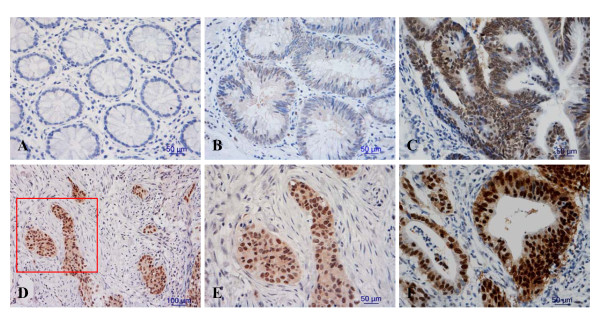
Immunohistochemical detection of CK2α expression in colorectal cancers, adenomas and adjacent normal colorectal mucosa. Staining was (A) negative in normal colorectal epithelium cells, (B, C) weak to moderate in the nuclei of colorectal adenoma cells, (D, E, F) and strong in the nuclei of colorectal cancer cells. (E is a close-up of the inset in D [framed in red]). Original magnification: × 200 (D), × 400 (A, B, C, E, F).